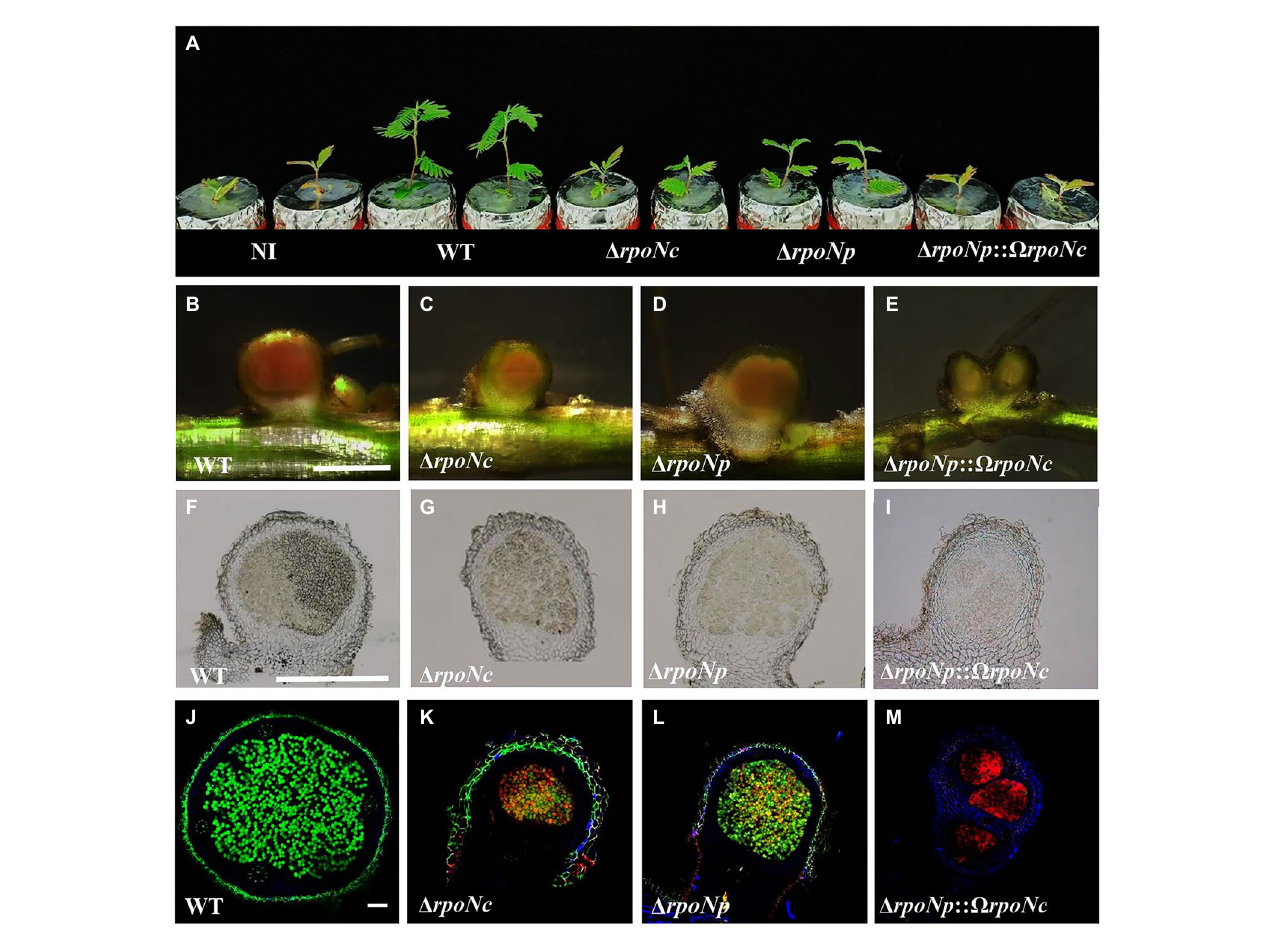
FIGURE 5 Aeschynomene americana (cv. Madagusga) plants grown in nitrogen-limiting conditions and inoculated with DOA9 WT and rpoN mutant strains at 20 dpi (A) , nodules as found on A. americana plants inoculated with WT and rpoN mutant strains at 20 dpi (B–E) . Thin nodule slices (50 μ m) observed under light (F–I) and confocal microscopy (J–M) . Indicated scale bars represent 1 mm (B–E) , 1.5 mm (F–I) , and 100 μ m (J–M) .